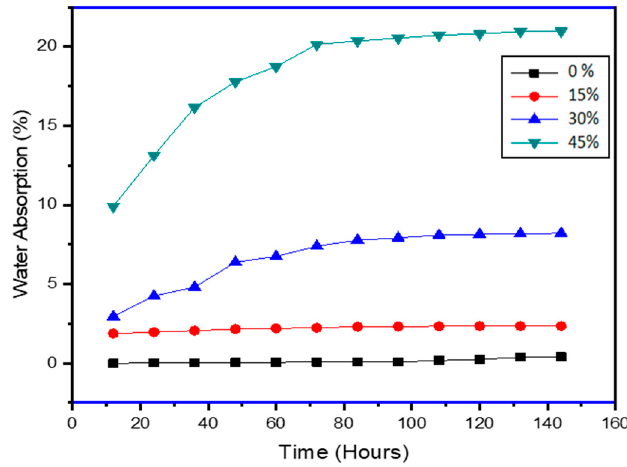
Figure 6. Water Absorption properties of PCL–PCP composites.